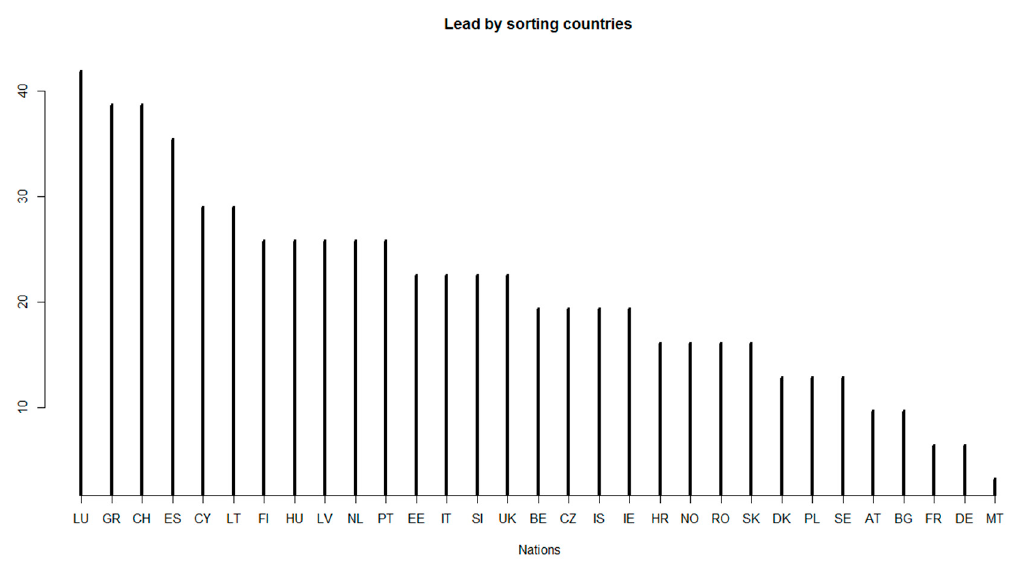
Figure 6. Ranking of follower countries.